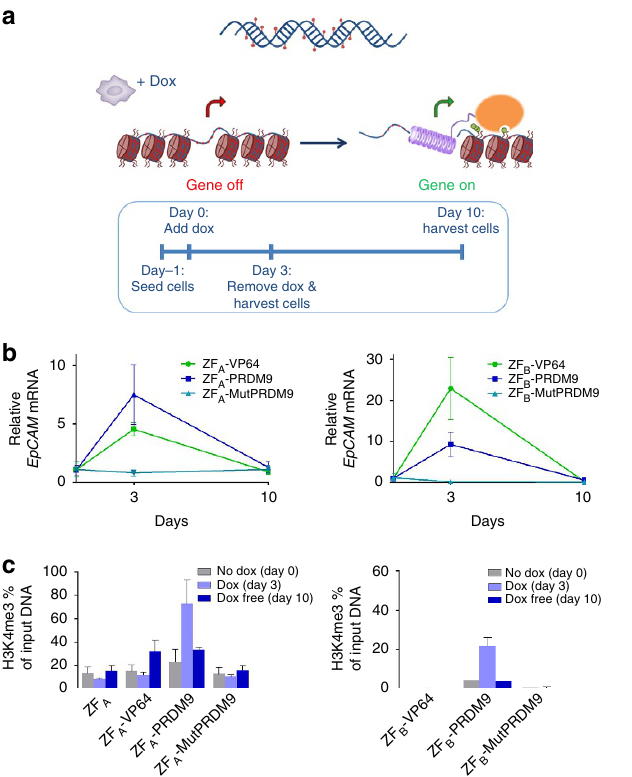
Figure 3 | Stability and maintenance of gene reactivation after induction of H3K4me3 in the hypermethylated EPCAM gene in HeLa cells. ( a ) Schematic representation of the stable doxycycline inducible system and the experimental timeline set-up. ( b ) Relative EpCAM messenger RNA (mRNA) expression, at each specific time point using two different ZFs targeting the promoter region. ( c ) H3K4me3 ChIP–qPCR enrichment at the promoter region of EpCAM at each specific time point. n ¼ 3 independent experiments; error bars ± s.d.